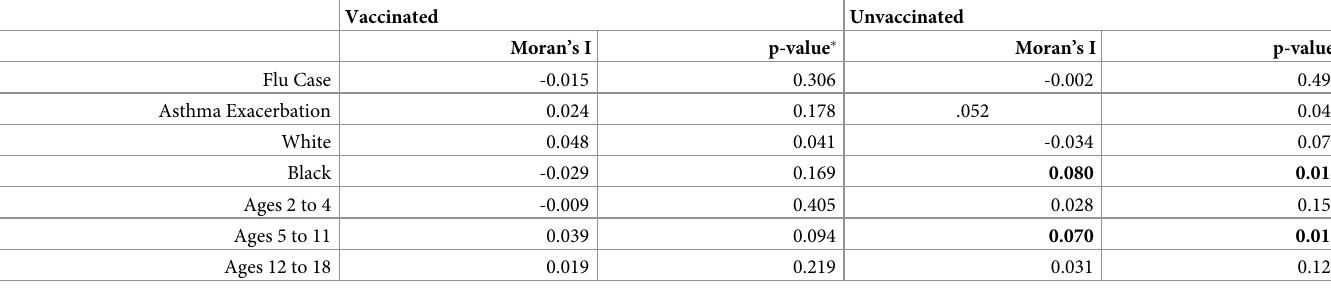
Table 4. Results of statistical analyses of Global Moran’s I measuring spatial